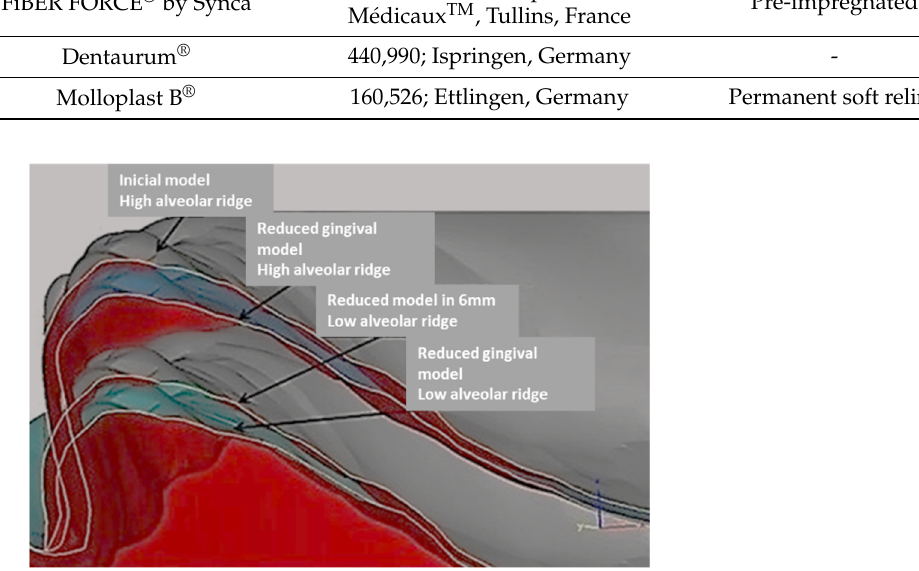
Figure 1. Computerised design of the four models reproduced using CAD-3D.